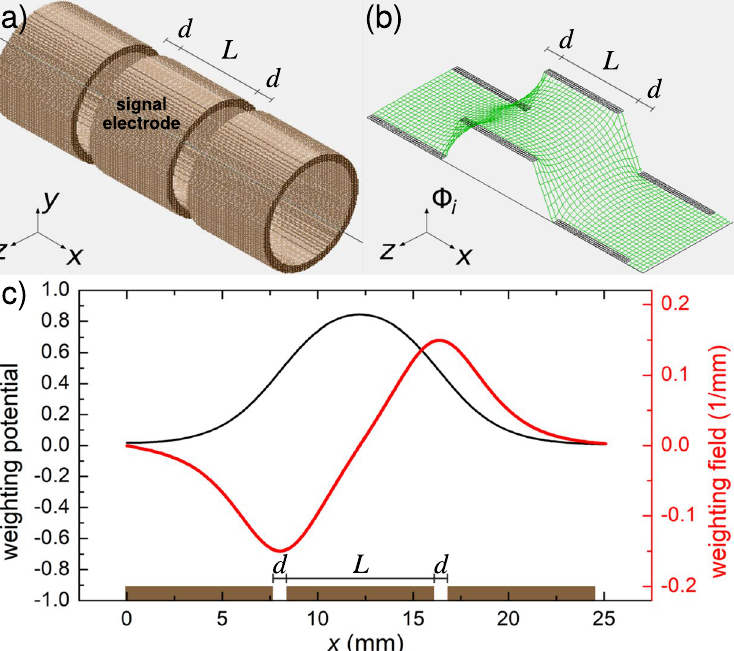
Figure 1. (a) Three cylindrical electrodes with symmetry axis as ion trajectory. L is the length of the central electrode, d is the spacing between the electrodes. (b) SIMION simulation of the weighting potential Φ i associated with the central electrode, ranging from 0 to a maximum value of 1. (c) Weighting potential and weighting field along the symmetry axis, i.e. the ion